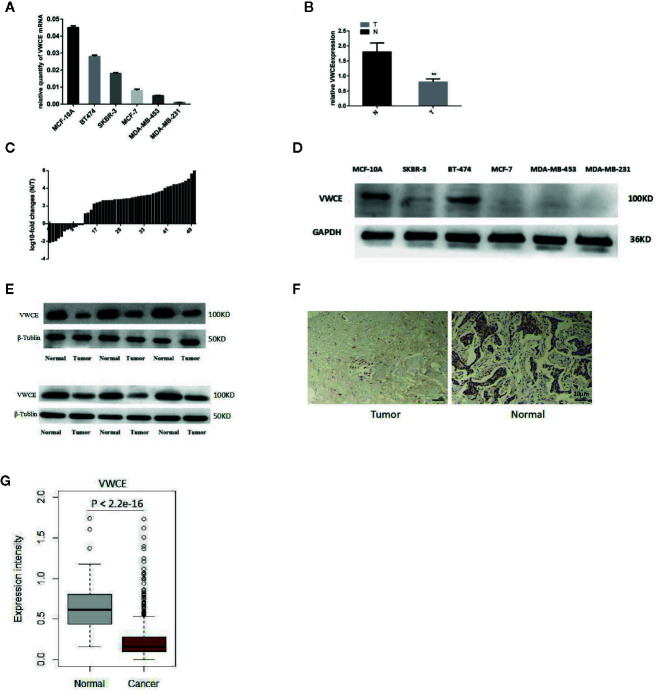
Down-regulation of Von Willebrand factor C and EGF domain (VWCE) in breast cancer tissues and breast cancer cell lines. (A) Quantitative real-time RT (RT-PCR) analysis of VWCE expression in five breast cancer cell lines (MCF-7, BT474, SKBR-3, MDA-MB-231, and MDA-MB-453) and a normal breast cell line (MCF-10A). (B) qRT-PCR analysis of VWCE mRNA expression in breast cancer tissues and matched normal control tissues. T, tumor; N, normal. (C) The expression of VWCE was analyzed in samples from 50 breast cancer patients. The height of the columns in the chart represents log10-transformed fold-changes (normal and cancer tissue) in VWCE expression. (D) Western blot analysis of VWCE protein expression in the five breast cancer cell lines and in MCF-10A cells. (E) Western blot analysis of VWCE protein expression in fresh breast cancer and adjacent non-tumor tissues. (F) Representative immunohistochemical staining of VWCE protein expression in breast cancer (right) and matched non-tumor tissues (left) (cale bar = 10 μM). (G) The level of VWCE mRNA expression was compared between the tumor and normal group of TCGA breast cancer. **P < 0.01.